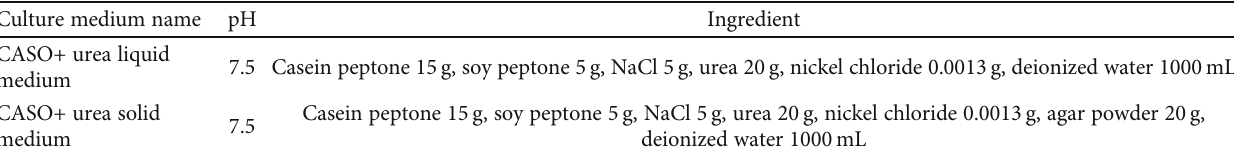
Table 1: Composition table of a medium for a test.